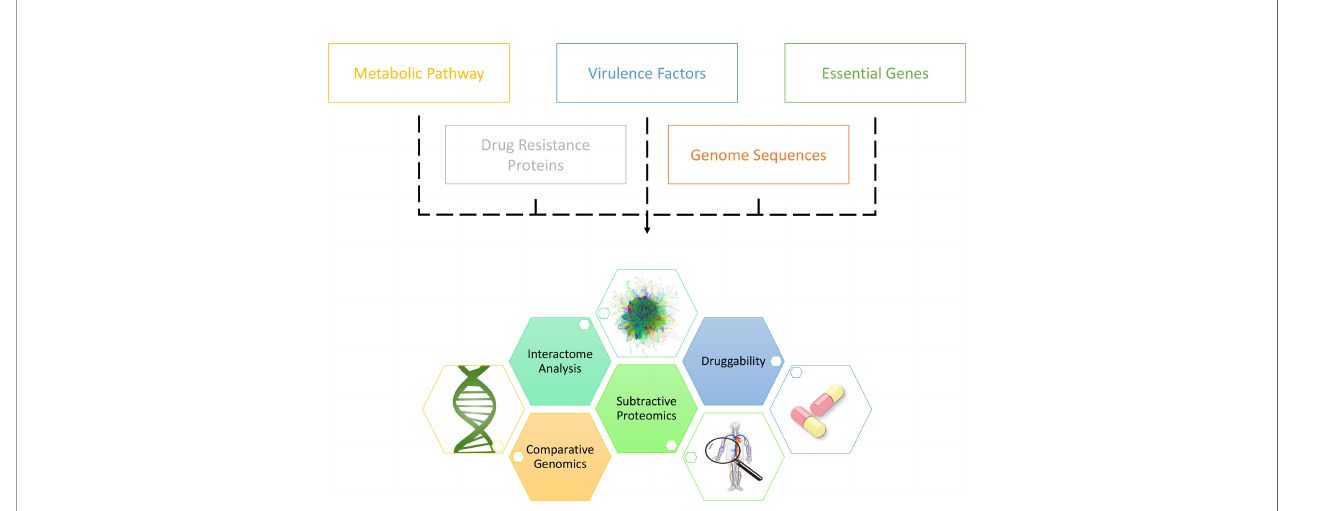
FIGURE 3 | Canonical work fl ow of unearthing novel drug targets in A. baumannii via the in silico